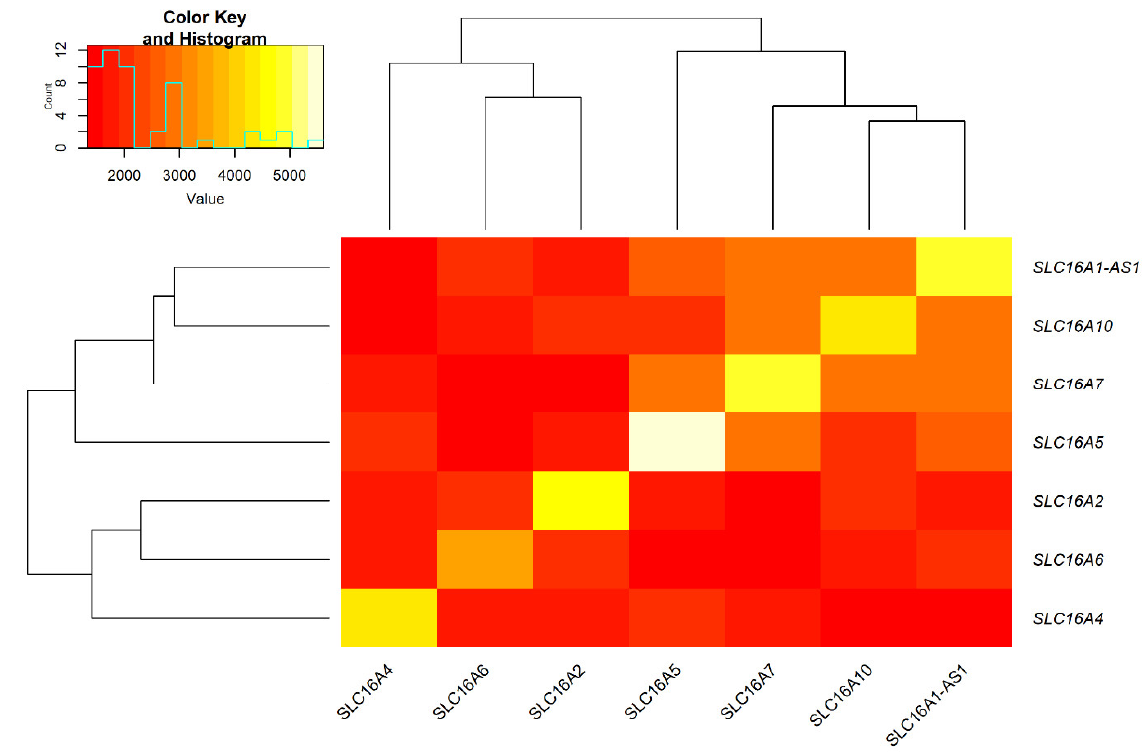
Figure A9. Hypernetwork heatmap of MCTs ( n = 6 transcripts) in PDAC stroma and epithelium that have been validated in the Birnbaum dataset. Colour intensity represents the number of binary relationships shared between a pair of transcripts with the rest of the transcriptome ( n = 12,440 total transcripts). Two clusters were identified, with cluster 1 having 4 MCTs with a higher connectivity (namely, SLC16A1-AS1 , SLC16A10 , SLC16A7 , and SLC16A5 ) and cluster 2 having 2 MCTs ( SLC16A4 and SLCA16A6 ) with relatively fewer correlations with the rest of the transcriptome.